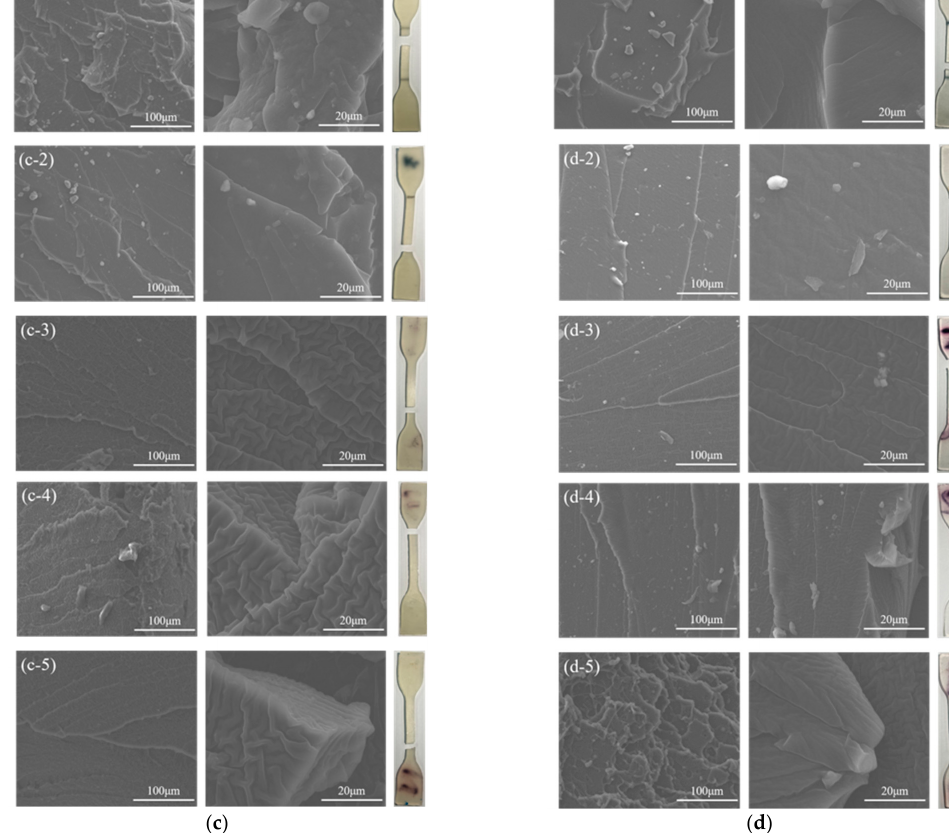
Figure 13. Scanning electron microphotographs of fracture of IPN matrix specimens. ( a ) S-N, ( b ) S-H, ( c ) S-T and ( d ) S-I. ( a - 1 ), ( a - 2 ), ( a - 3 ), ( a - 4 ) and ( a - 5 ) were the crack morphology of S-N binder specimen at –40 °C, –20 °C, 0 °C, +20 °C, +50 °C, respectively; ( b - 1 ), ( b - 2 ), ( b - 3 ), ( b - 4 ) and ( b - 5 ) were the crack morphology of S-H binder specimen at –40 °C, –20 °C, 0 °C, +20 °C, +50 °C, respectively; ( c - 1 ), ( c - 2 ), ( c - 3 ), ( c - 4 ) and ( c - 5 ) were the crack morphology of S-T binder specimen at –40 °C, –20 °C, 0 °C, +20 °C, +50 °C, respectively; ( d - 1 ), ( d - 2 ), ( d - 3 ), ( d - 4 ) and ( d - 5 ) were the crack morphology of S-I binder specimen at –40 °C, –20 °C, 0 °C, +20 °C, +50 °C, respectively.